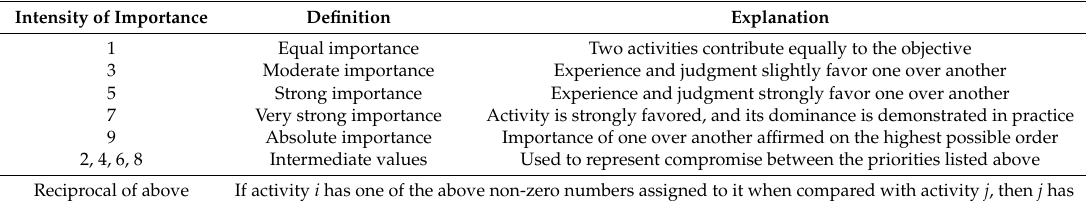
Table 1. Saaty’s 1–9 scale for analytic hierarchy process (AHP)